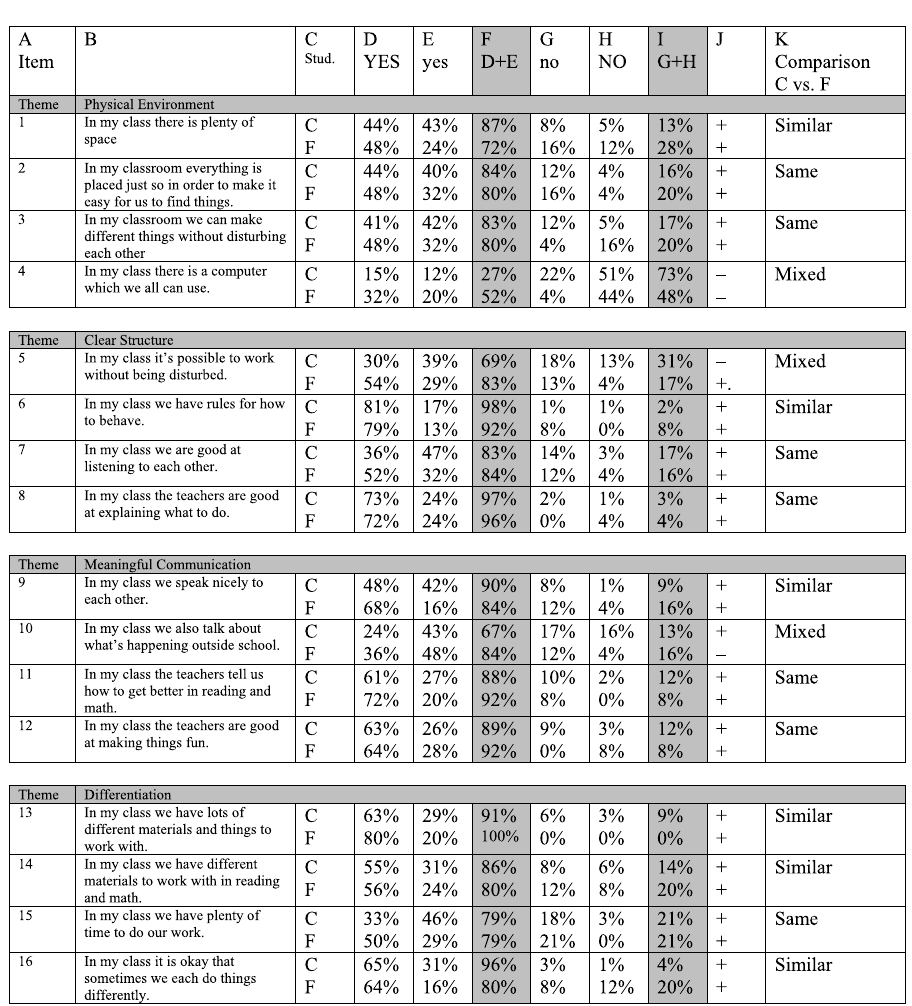
Figure 3. Portion of consolidated table, students’ opinion of class